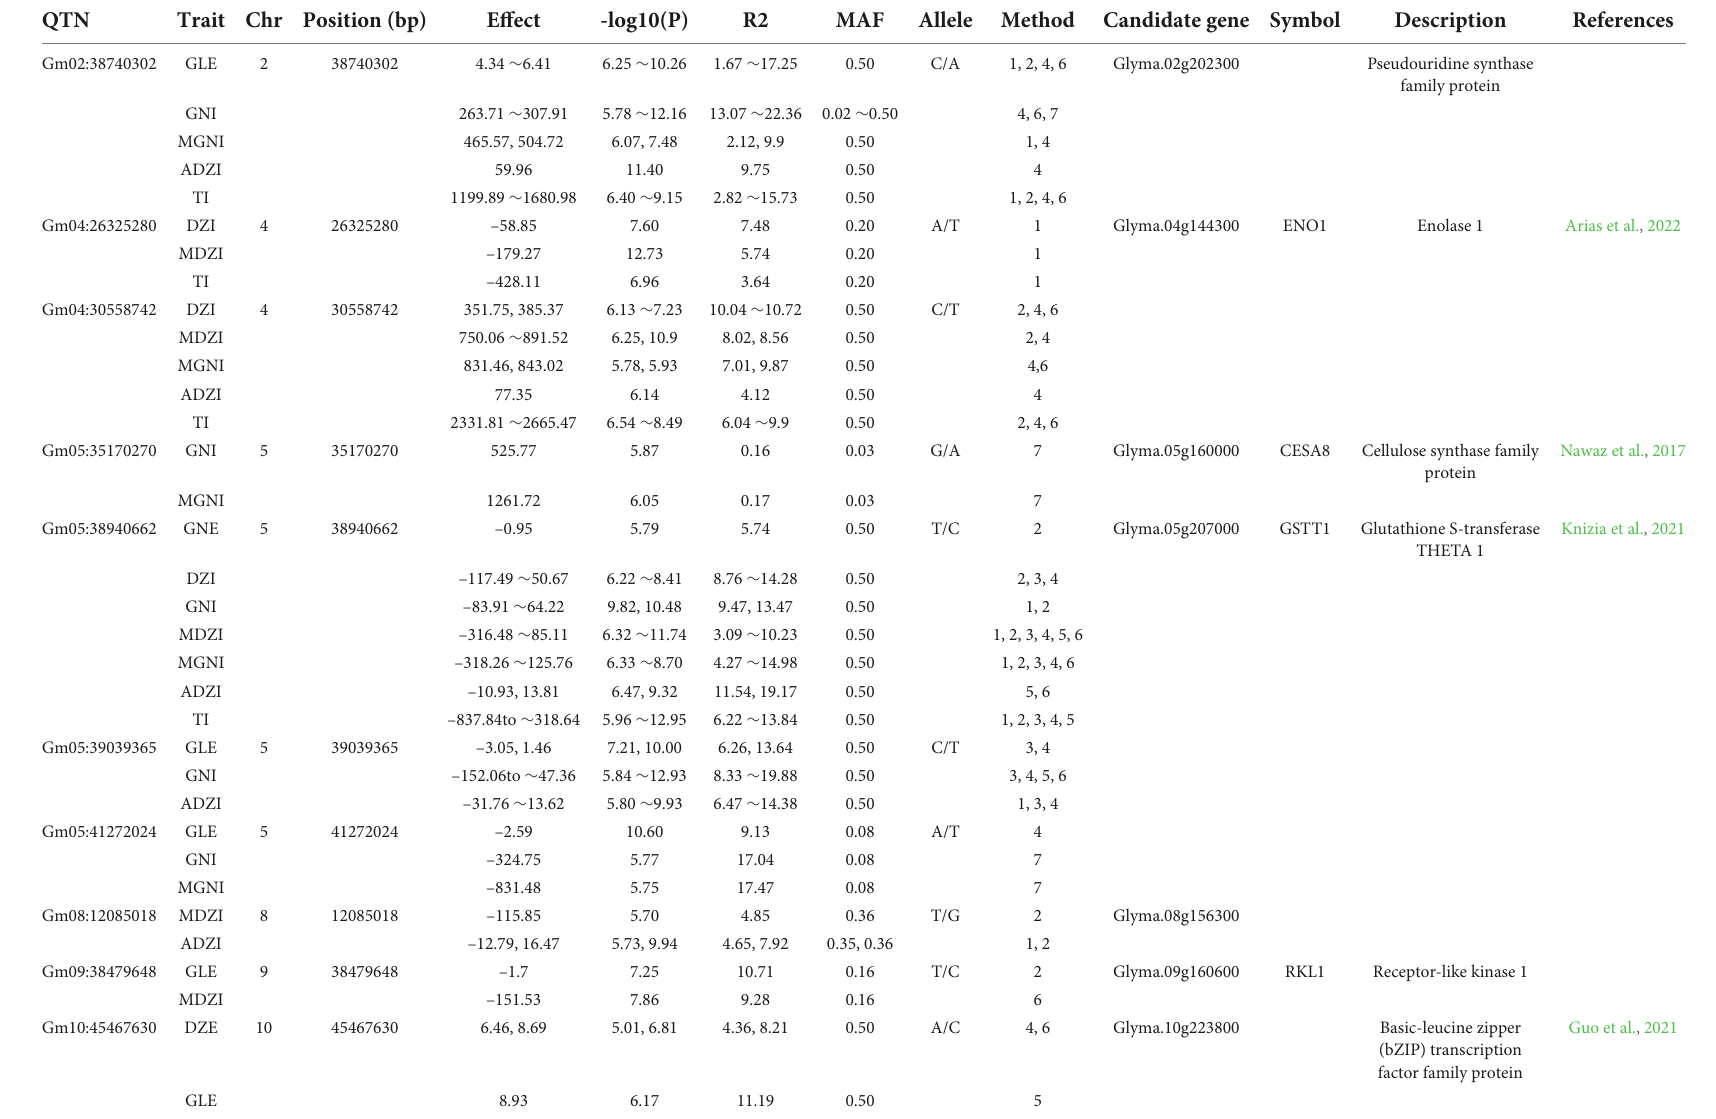
TABLE 2 Information about co-detected QTNs for isoflavone contents in 2020 using MLM-based models.